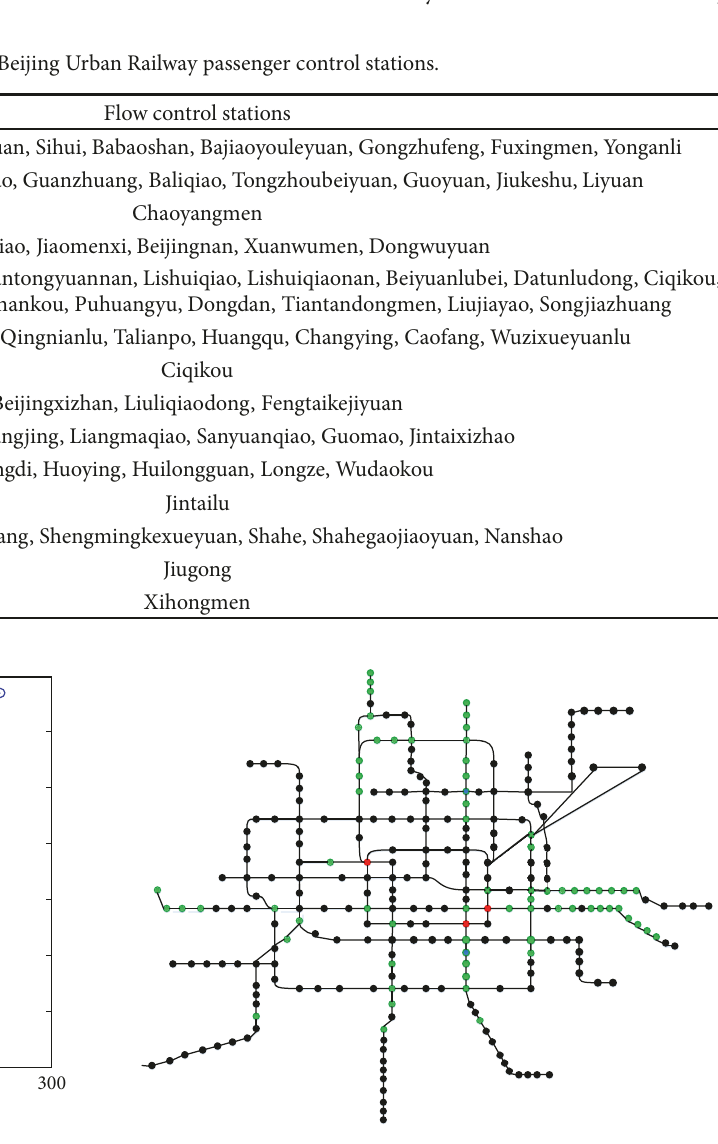
Figure 6: Control stations of Beijing urban rail transit under the network controllability